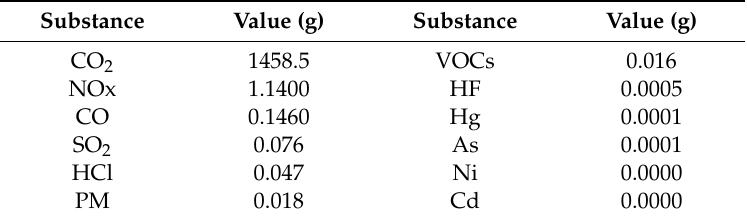
Table 4. Emissions to the air resulting from the gasification process (per 1 kg of dry matter of swine manure